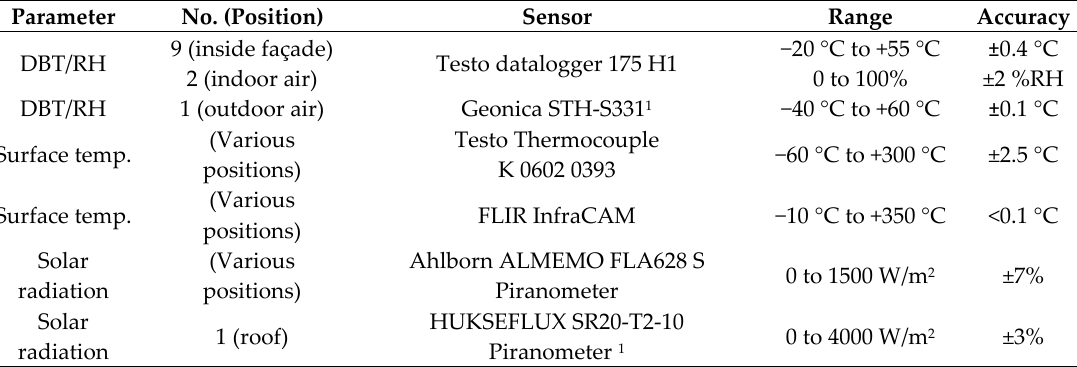
Table 1. Measurements performed, with sensors and specifications. DBT: dry-bulb temperature; RH: relative